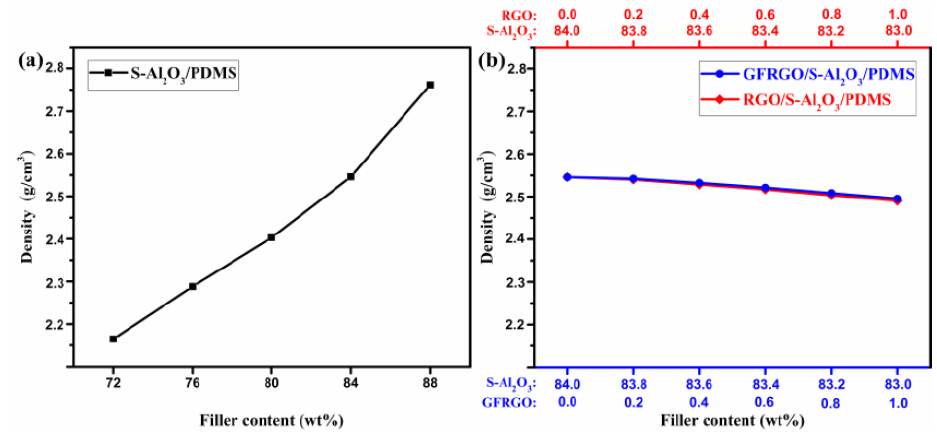
Figure 4. Density of ( a ) S-Al 2 O 3 /PDMS composites and ( b ) GFRGO/S-Al 2 O 3 /PDMS and RGO/S- Al 2 O 3 /PDMS composites with different filler contents.